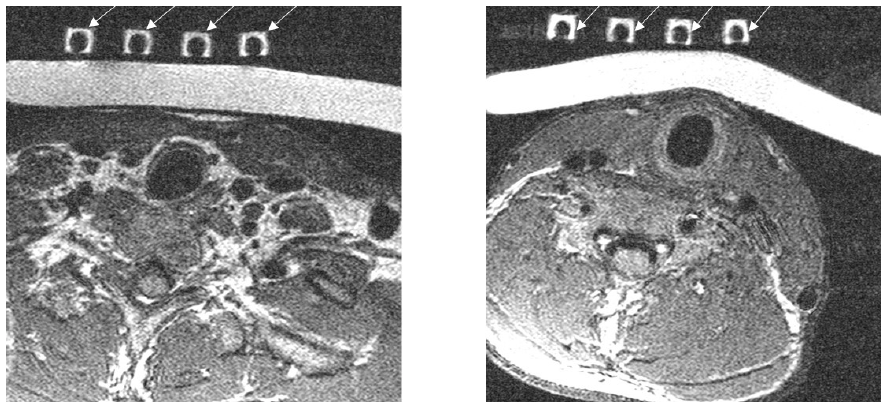
Figure 8. Examples of MR images obtained using the simultaneous multimodality imaging system. Each image corresponds to a cross section, and rows of fiducial marker arrays are indicated by arrows. The probe was equipped with two rows of marker arrays, as shown in Figure 1.